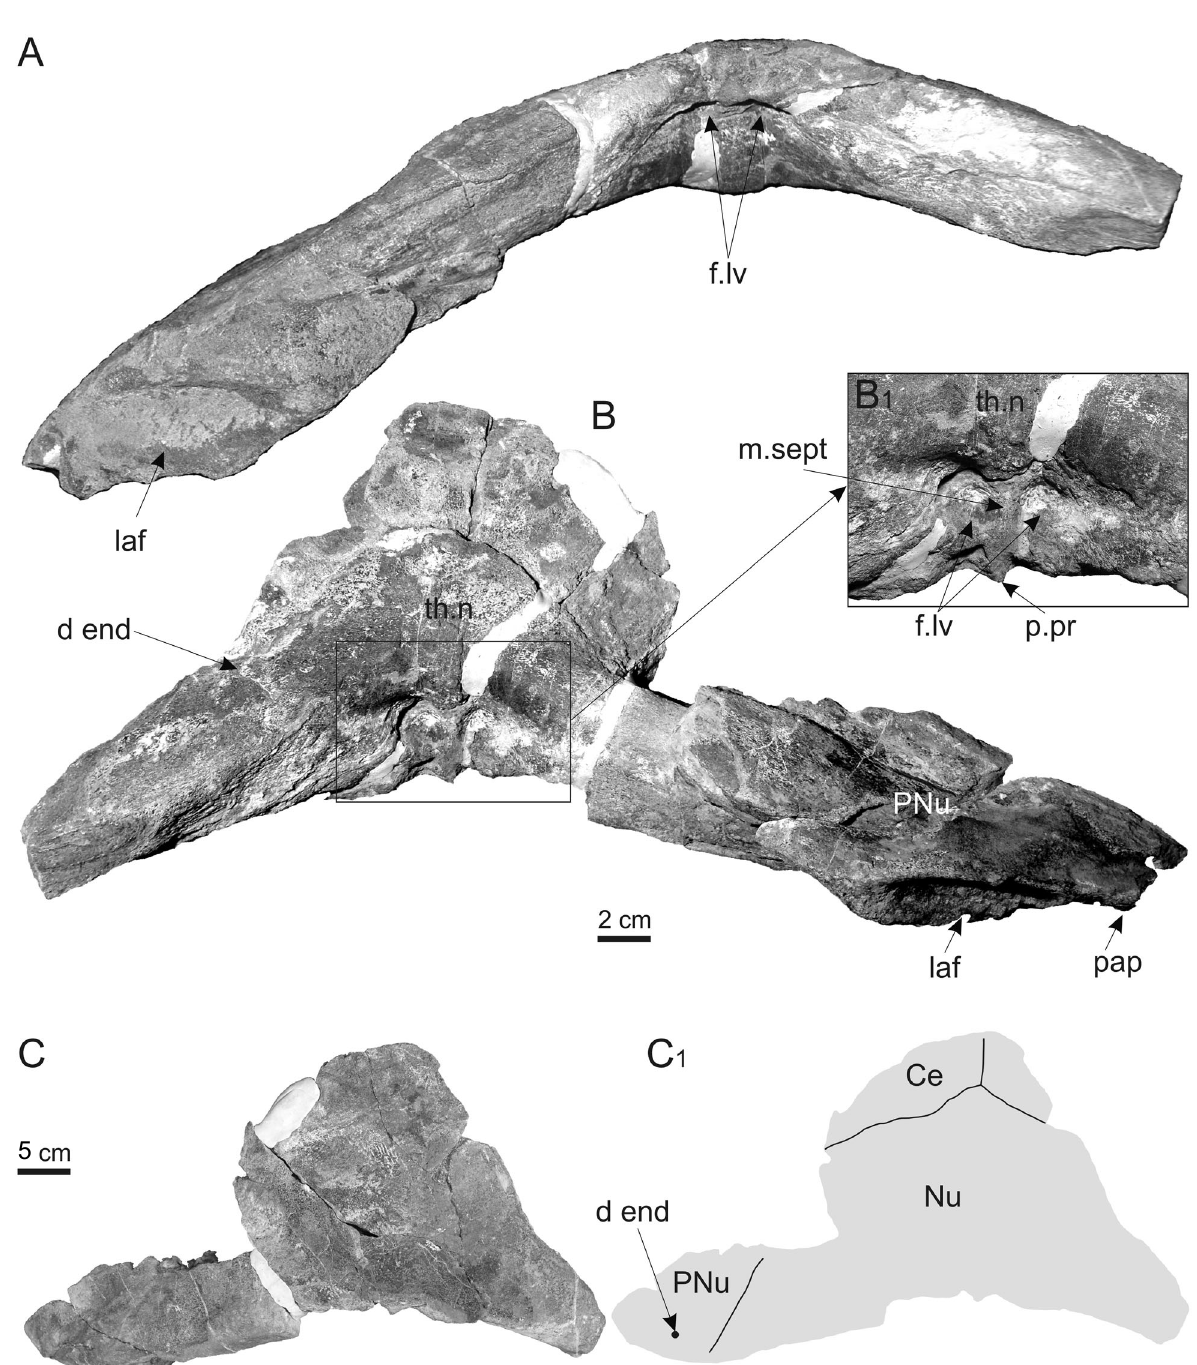
Fig. 2. Fragments of the head shield of Dunkleosteus sp. A , specimen Muz. PGI-NRI 1809.II.18, back view. B , specimen Muz. PGI-NRI 1809.II.18, visceral view. B1 , magnified fragment of fig. B. C , specimen Muz. PGI-NRI 1809.II.18, external view. C1 , sketch of the external view of the specimen on C. Abbreviations for Figs 2, 4 and 6: Ce, central plate; d end, opening of the endolymphatic duct; dp. m. cu., cucullaris depression; f.lv, levator pits; laf, lateral articular fossa; m.sept, median septum; Nu, nuchal plate; PNu, paranuchal plate; pap, para-articular process; p.pr, posterior process of the nuchal plate; PrO f., contact face for the preorbital plate; ppt, pineal pit; th.n, nuchal thickening; th.pre, pre-endolymphatic thickening.